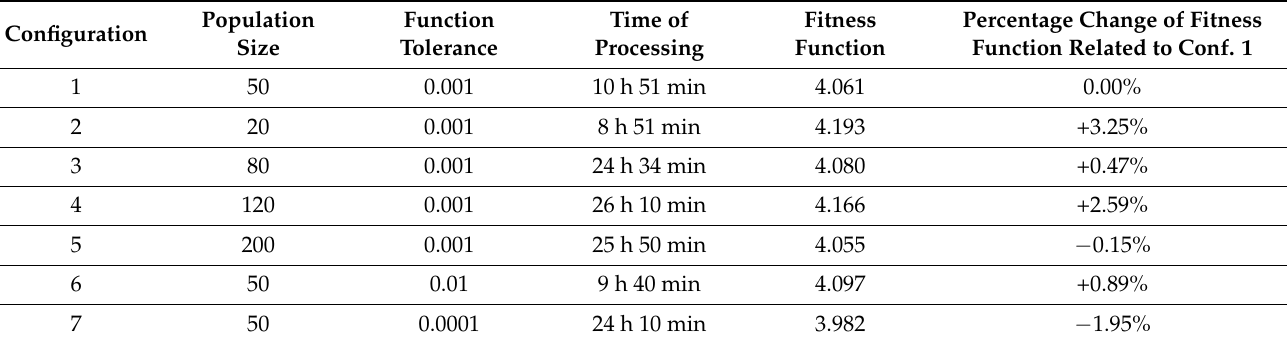
Table 5. GA parameters and result